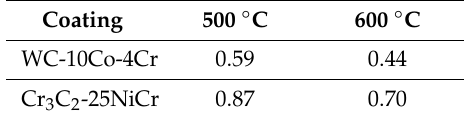
Table 6. Friction coe ffi cient of the coatings at the testing temperature